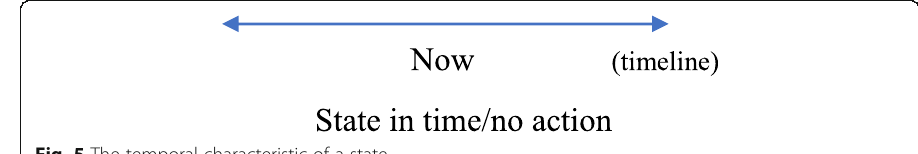
Fig. 5 The temporal characteristic of a